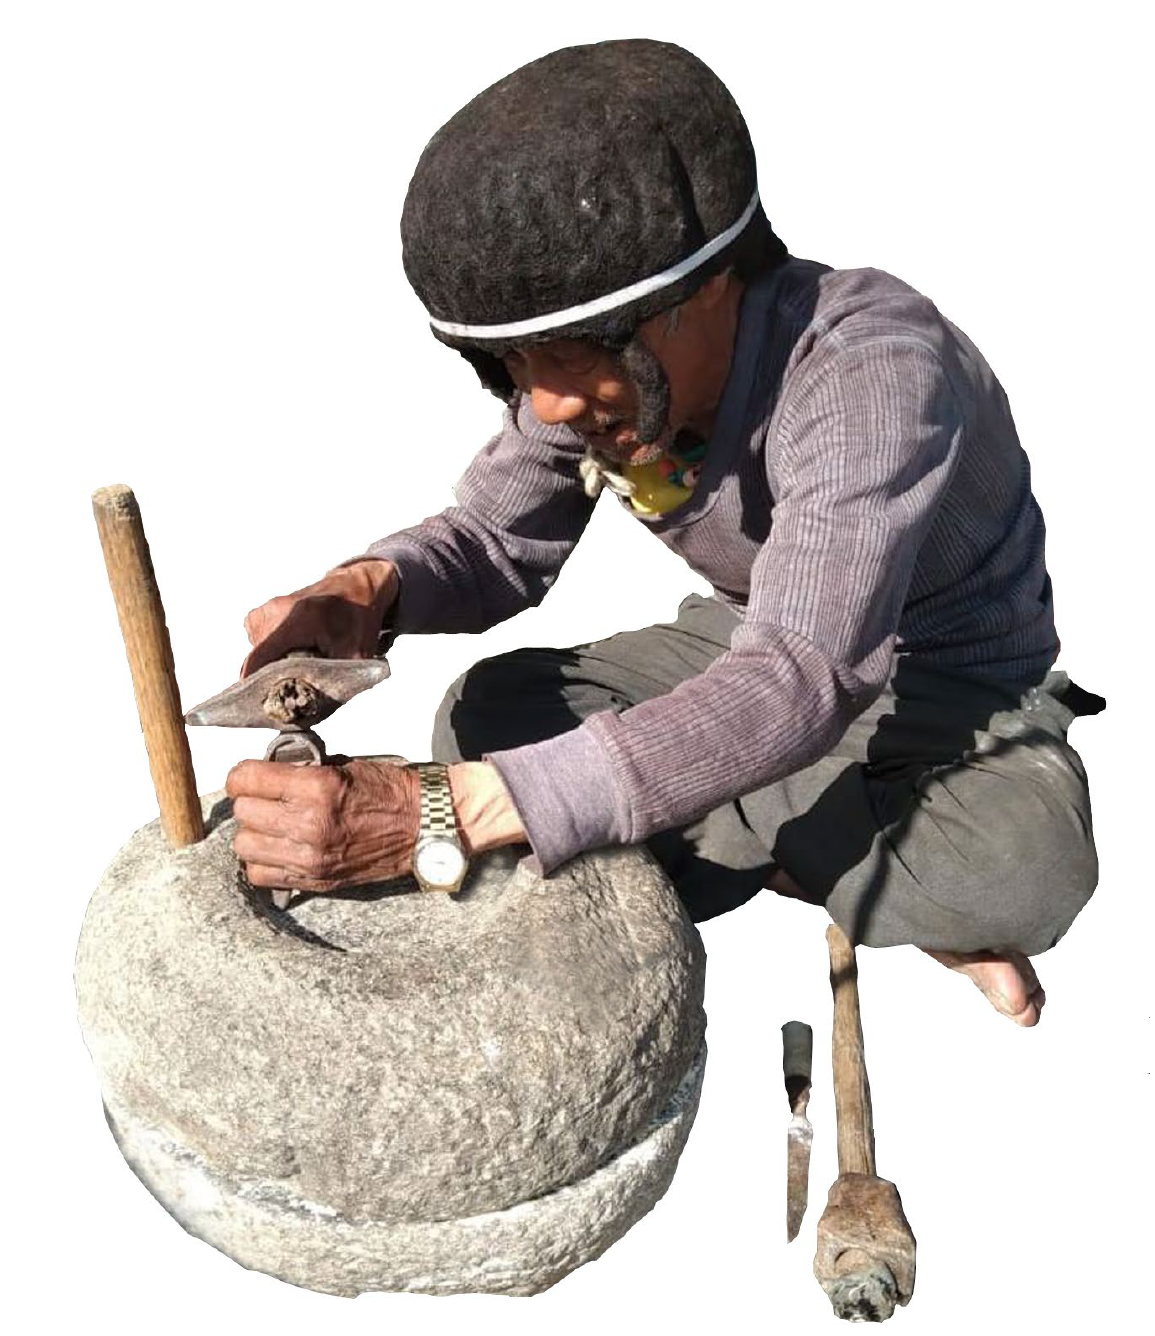
Figure 2. Rinchin Dorjee Megeji ( Zyopo ) at work (Photo by K. D.